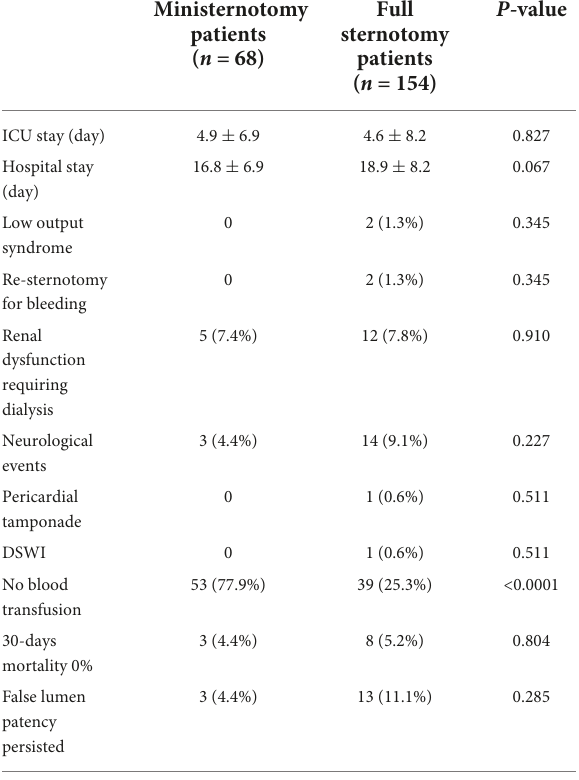
TABLE 3 Postoperative outcomes.